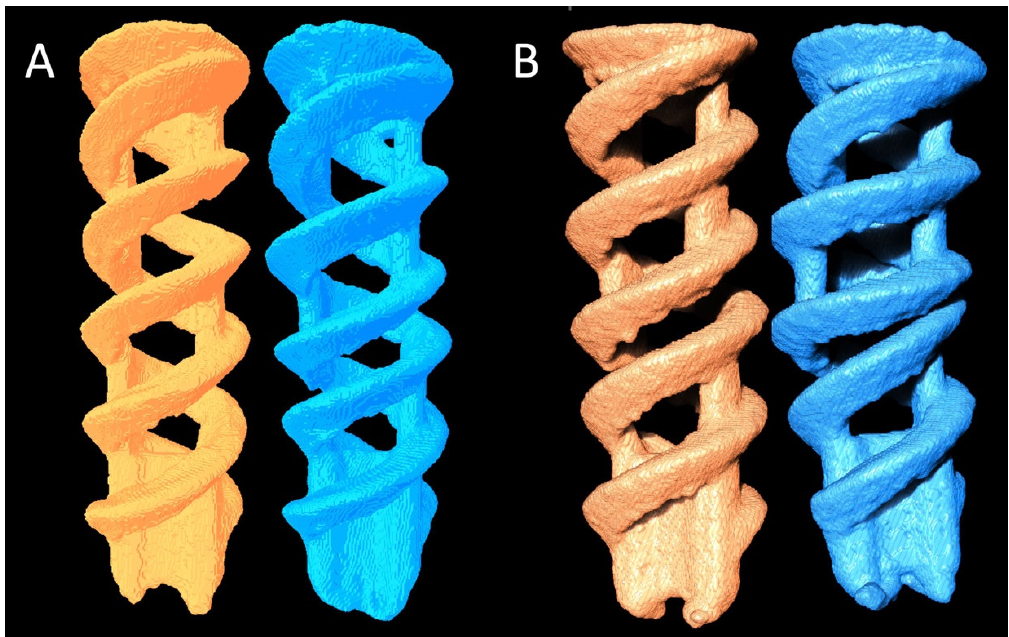
Figure 14. Reconstructed micro-CT images of two Fe SAs ( A ) 2 weeks postoperation and ( B ) 6 weeks postoperation.